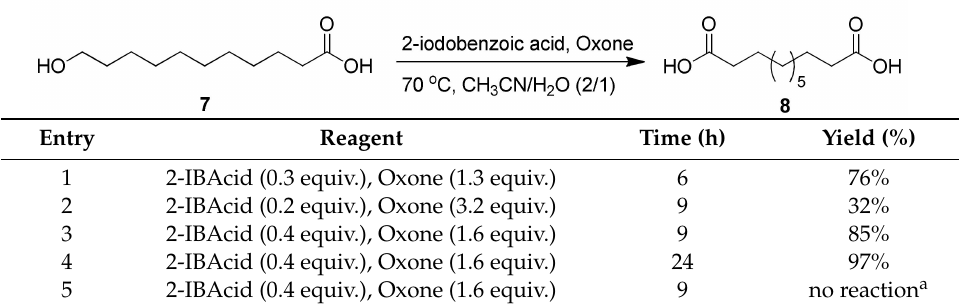
Table 2. 2-Iodobenzoic acid / Oxone-mediated oxidation.